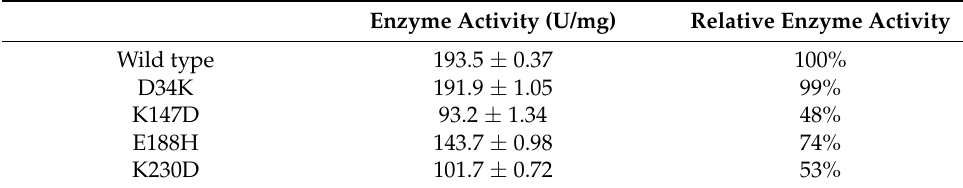
Table 2. Enzyme activity of wild type and mutant.